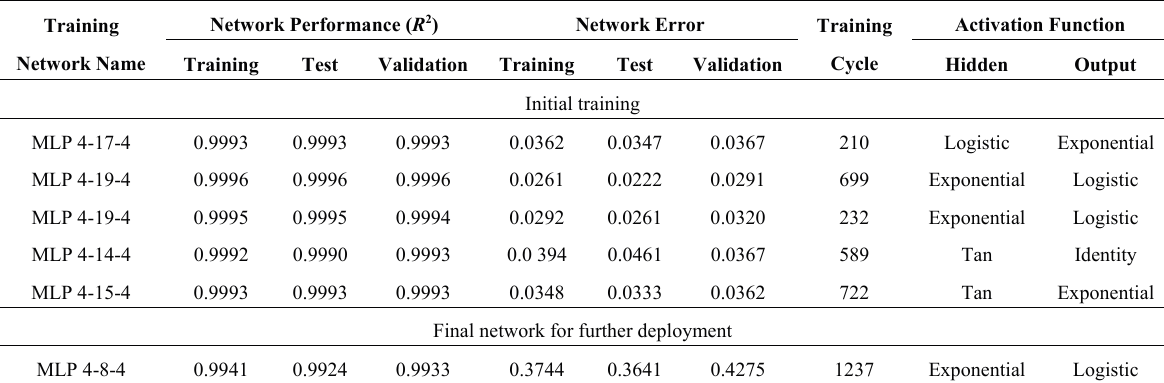
Table 2. Results of the neuronal network learning